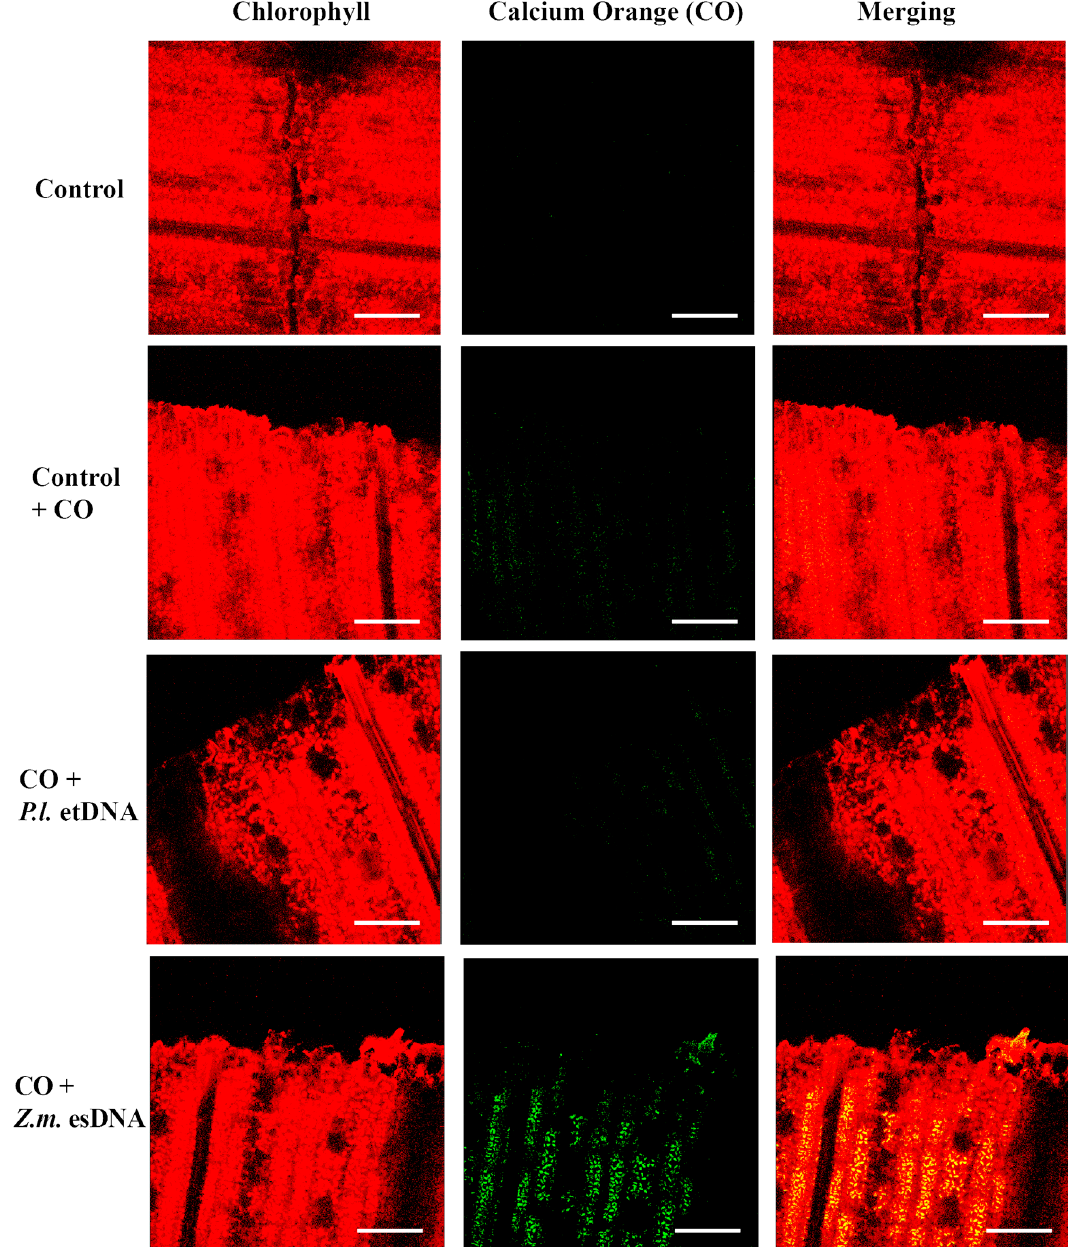
Figure 5. Intracellular calcium variations in maize leaves upon different treatments. False-color image analysis reconstructions from confocal laser-scanning microscope observations, and fluorochemical intracellular Ca 2+ localization. Fifty microliters of 200 µg·mL − 1 of either esDNA or etDNA were applied, and after 30 min the calcium signature was observed. Pictures represent portions of the maize leaf blade where the green fluorescence refers to binding of calcium orange with Ca 2+ , whereas the chloroplasts are evidenced by a bright red color caused by chlorophyll fluorescence. Scale bar (100 µm) is indicated on the figures. CO, calcium orange; P.l. , Phaseolus lunatus ; Z.m ., Zea mays . Image analysis of calcium orange fluorescence confirmed the increased trend of [Ca 2+ ] c in esDNA-treated leaves (Figure 6). In both Lima bean and maize, only a faint fluorescence was found after perfusion with etDNA; however, image analysis (see also Section 4.4) indicated that no significant differences in [Ca 2+ ] c were found between etDNA treatments and controls (Figure 6).